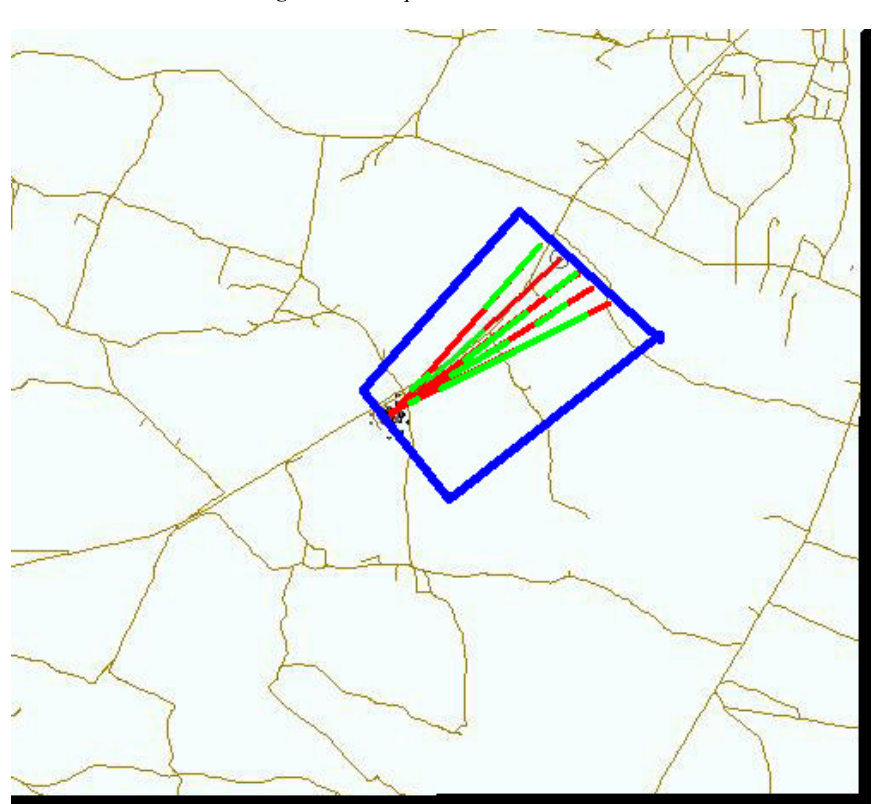
Fig 2. A selected attack